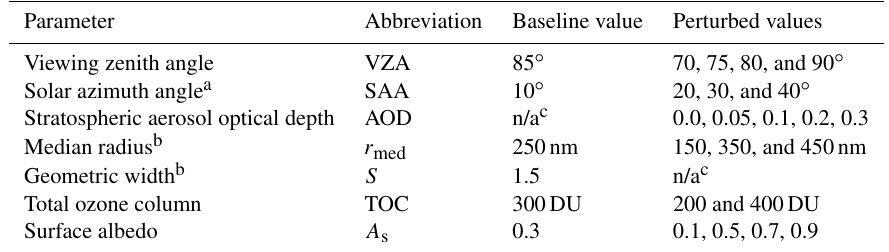
Table 1. Compilation of the relevant input parameters for the SCIATRAN simulations. Note that the solar zenith angle (SZA) is varied for all case studies in the range of 40–96 ◦ .